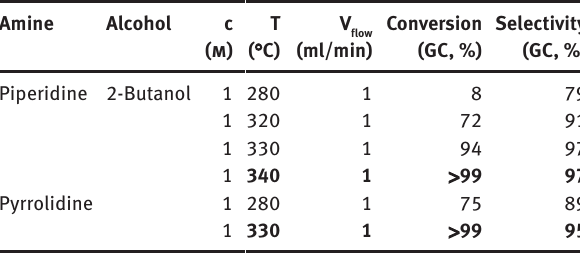
Amine Alcohol c